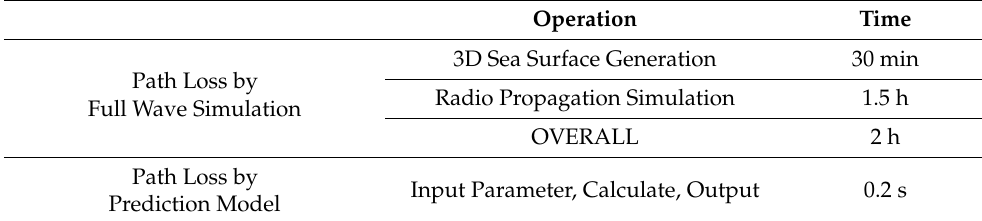
Table 6. Computation Time for Simulation and